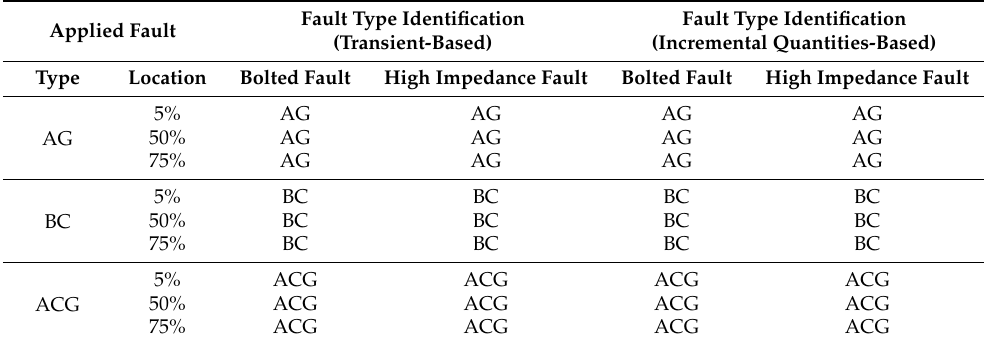
Table 5. Fault type identification of transient/incremental quantities-based faulted phase identifica- tion